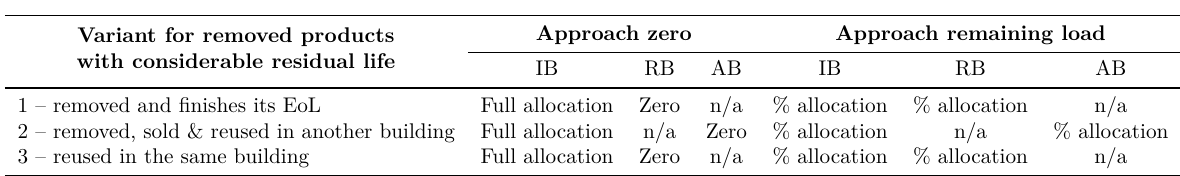
Table 2. Different ways of allocating removed elements with residual service life. Note: ‘IB’ = initial building; ‘RB’ = refurbished building; ‘AB’ = another building outside the system; ‘%’ = proportional to remaining service life; ‘n/a’ = not